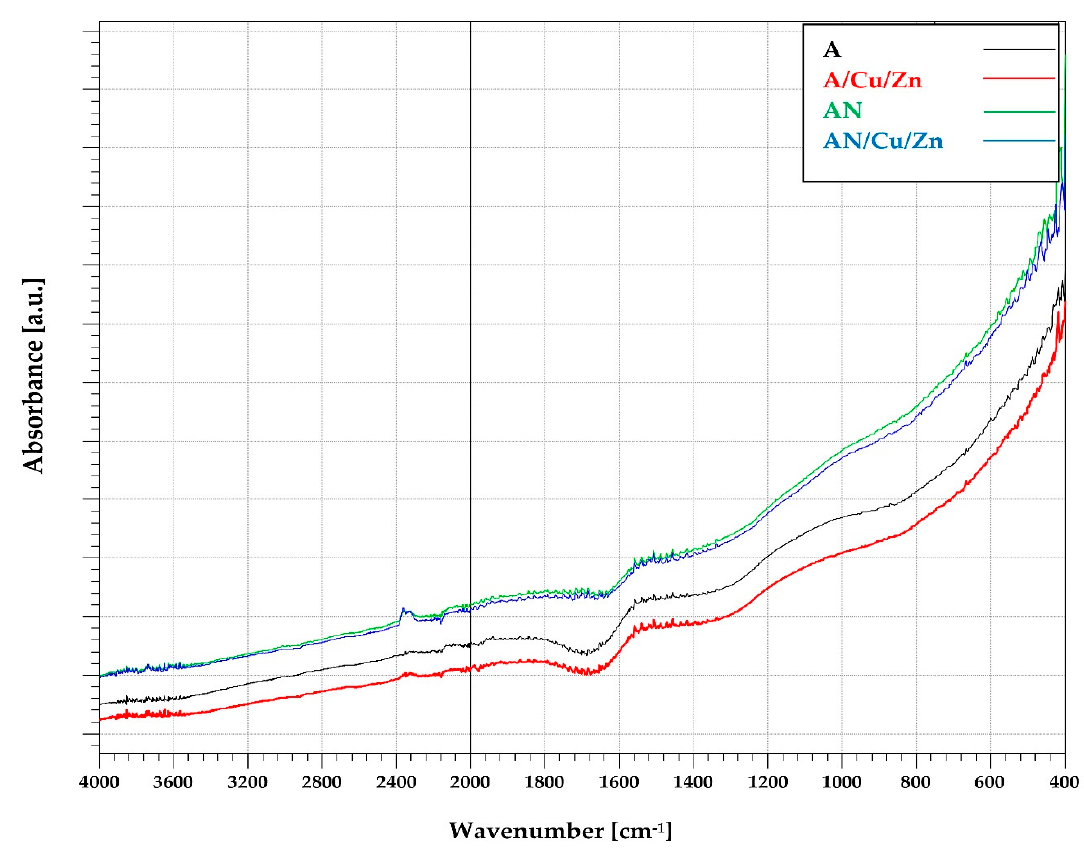
Figure 7. The FTIR spectra of the activated carbons before and after Cu(II) and Zn(II) ions’ adsorption (pH: 6, heavy metal ions’ concentration: 10 mg/L, mass of adsorbent: 0.01 g, time 240 min, shaking speed 180 rpm).